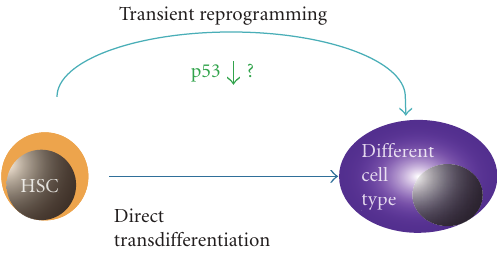
Figure 3: Possible mechanisms of HSC transdi ff erentiation. HSCs might directly transdi ff erentiate into another cell type (lower arrow) or through transient reprogramming in certain conditions. Loss of p53 might promote transient reprogramming for HSC transdi ff